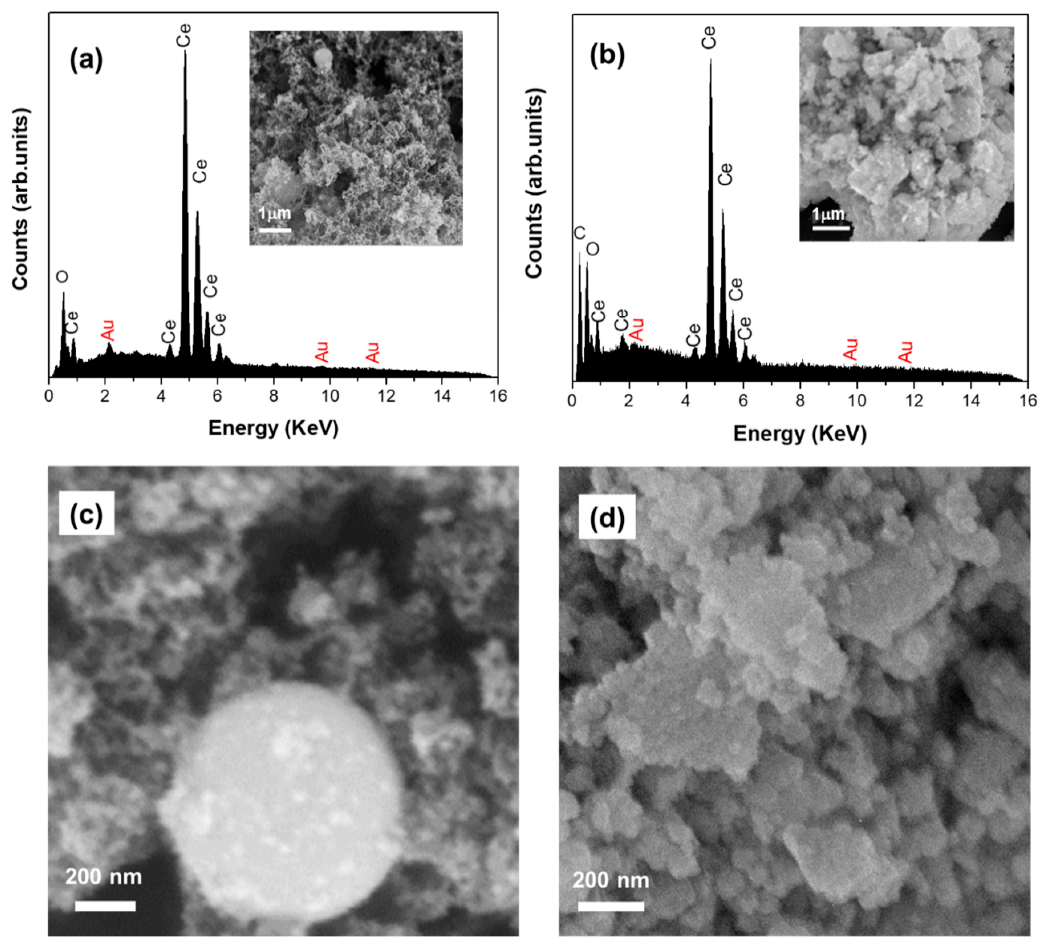
Figure 2. SEM micrographs and Energy Dispersed X-ray (EDX) spectra of fresh 5% Au/CeO 2 Figure2. SEMmicrographsandEnergyDispersedX-ray(EDX)spectraoffresh5%Au / CeO